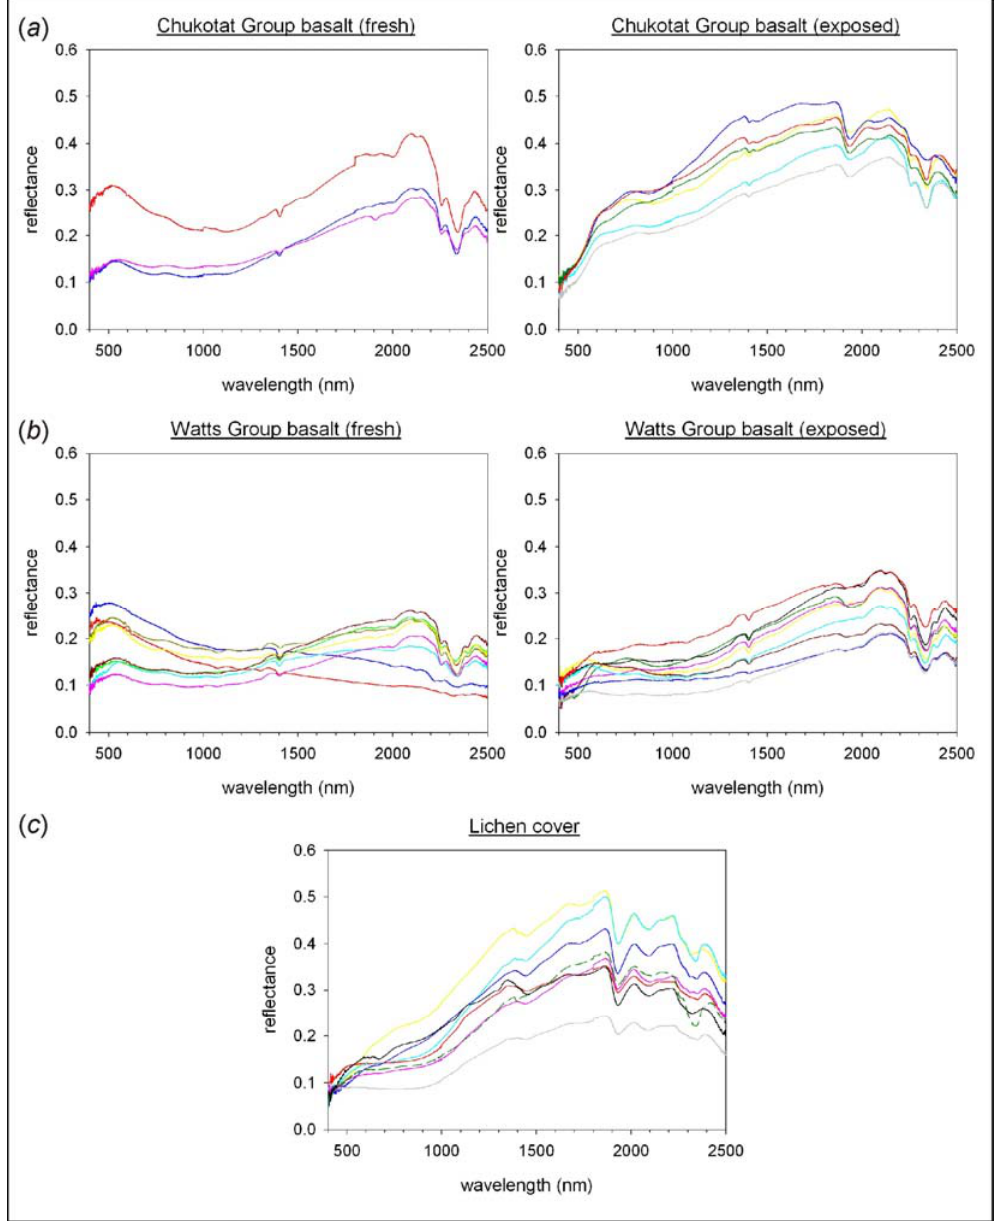
Figure 9. Reflectance spectra typical of fresh (left) and exposed (right) surfaces in the study area for ( a ) mafics of the Chukotat Group and ( b ) mafics of the Watts Group. ( c ) Reflectance properties typical of lichen